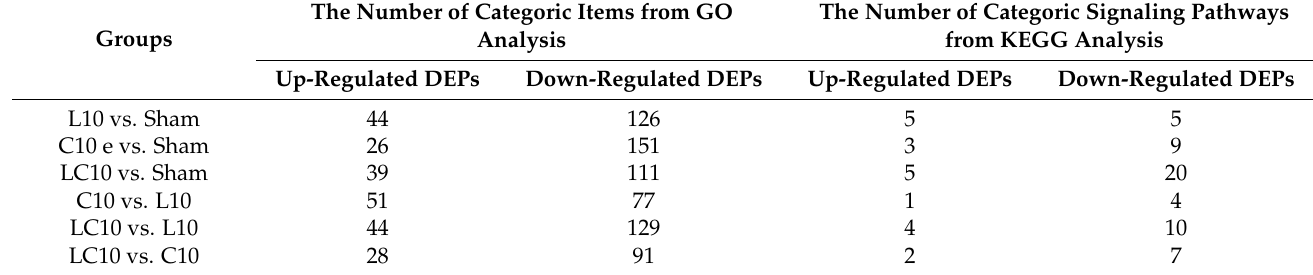
Table 5. The gene set enrichment analysis of DEPs after compound microwave exposure in peripheral